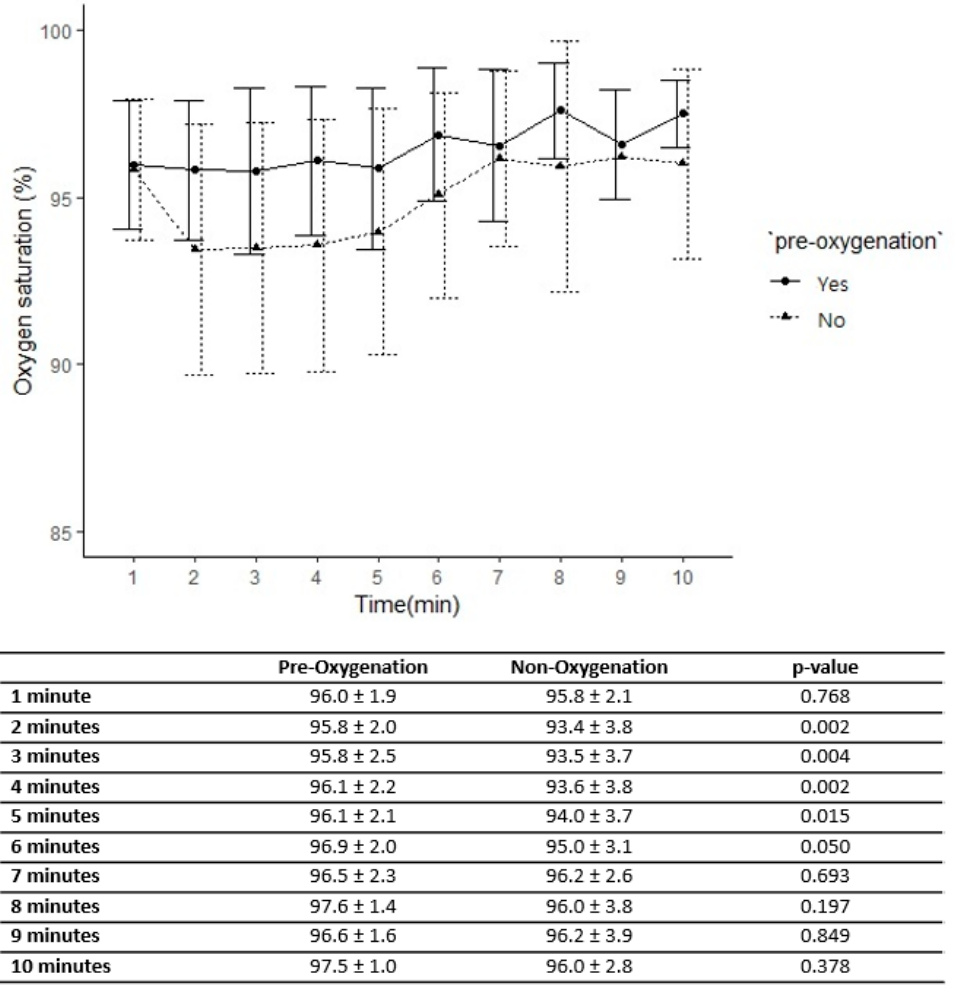
Figure 1. The trend of mean oxygen saturation (%) by times (1 min interval) in both groups.